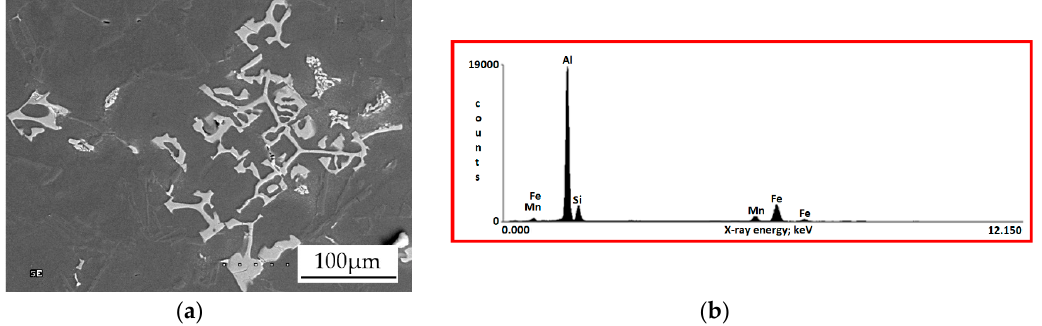
Figure 3. Precipitation of Al 15 (Fe,Mn) 3 Si 2 phase ( a ) with a histogram of the concentration of the constituent elements ( b ).